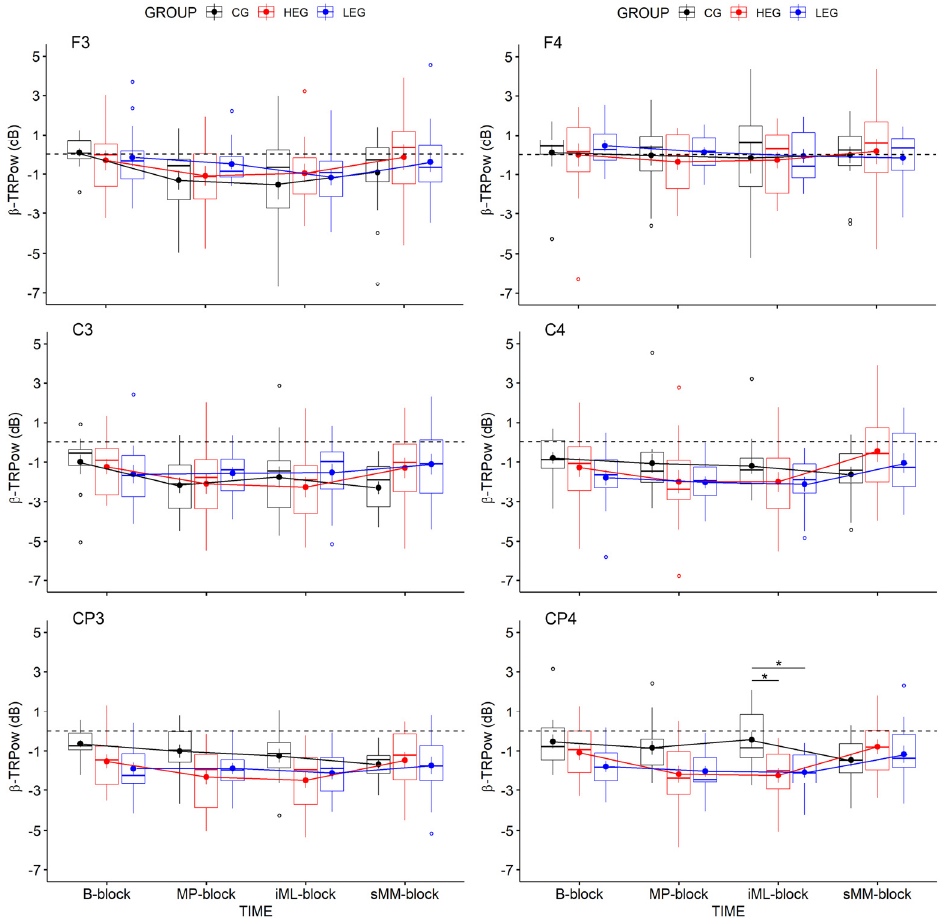
Figure 5. Illustration of changes in β -TRPow over the 4 measurement blocks included in the statistical analyses: Boxplots shown contain RMSE means and ( ± ) SEM per group (HEG, LEG, and CG). Negative values indicate decreased TRPow, representing increased cortical activation. Outliers are marked as values below the first quartile (–1.5 × IQR) or above the third quartile (+1.5 × IQR). *: p < 0.05 (see Supplementary Table S3 for mean values and SD of β -TRPow).